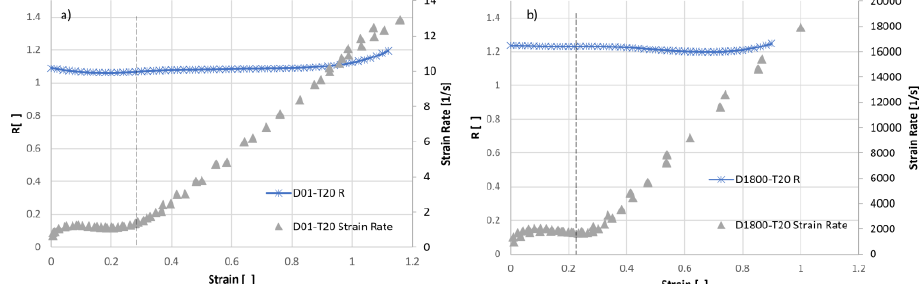
Fig. 7. True strain rate histories and dynamic amplification histories (double vertical axis) from dynamic tests at 1 s -1 (a) and 1800 s -1